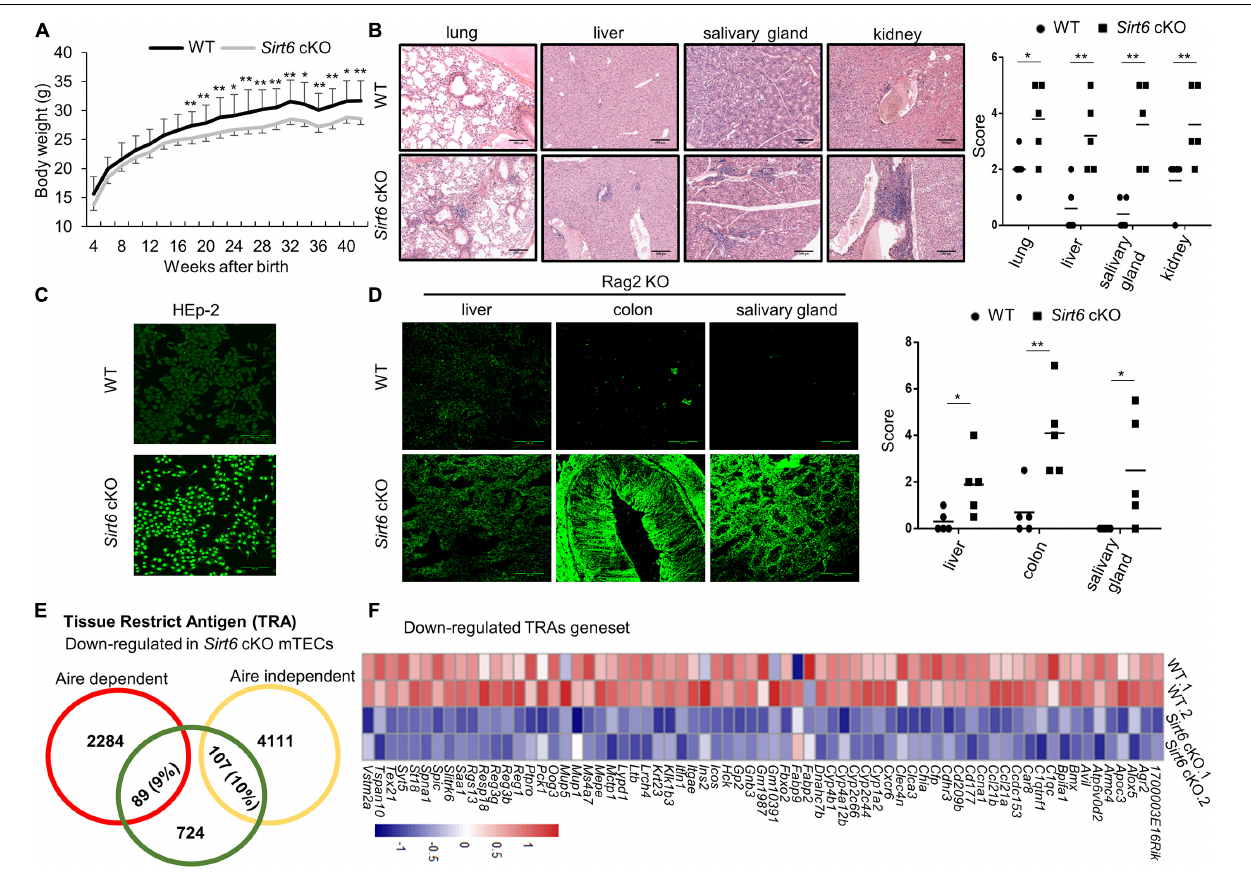
FIGURE 6 | Sirt6 cKO mice spontaneously develop severe autoimmune disorder. (A) Curve of body weight with age of wild-type and Sirt6 cKO mice. (B) Hematoxylin and eosin (H&E) stained paraffin embedded sections of lung, liver, salivary gland, and kidney of 8-month-old wild-type and Sirt6 cKO mice. Infiltration scores and means are indicated. Scale bars: 200 µ m. (C) Antinuclear antibodies from the serum of 8-month-old wild-type and Sirt6 cKO mice combined with HEp-2 cell line then detected by anti-mice IgG-AF488 antibody. Scale bars: 100 µ m. (D) Tissue sections (liver, colon, and salivary gland) of Rag2 knockout mice were incubated with the serum of 8-month-old wild-type and Sirt6 cKO mice to detect autoantibodies. Scores and means are indicated. Scale bars: 100 µ m. (E) The downregulated of Aire-dependent and Aire-independent TRA genes in the comparison of wild-type and Sirt6 deficient mTEC were calculated in venn diagram. Aire-dependent genes were circled in red and Aire-independent genes were circled in yellow. (F) Heatmap of the downregulated TRAs genes ( p < 0.05) in Sirt6 deleted mTEC. N ≥ 5 per group. * p < 0.05 and ** p < 0.01 (Student’s t